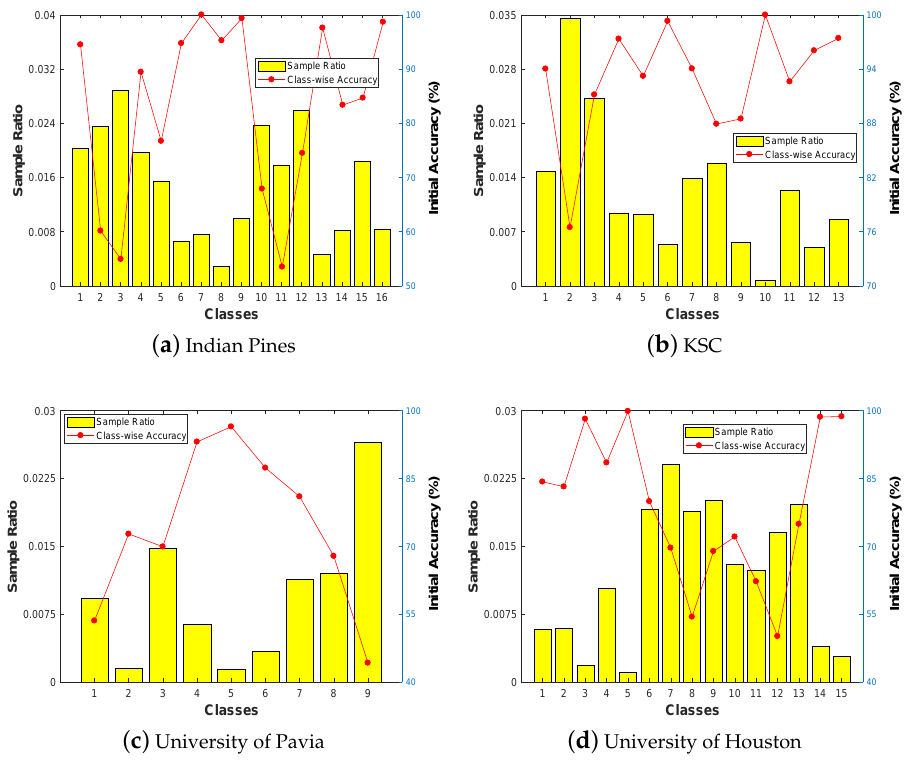
Figure 10. The ratios of the selected samples to the corresponding classes of the IEUE method (see the histograms) and the initial class-wise accuracies (see the accuracy curves) for the four datasets. ( a ) Indian Pines, ( b ) KSC, ( c ) University of Pavia, ( d ) University of Houston.